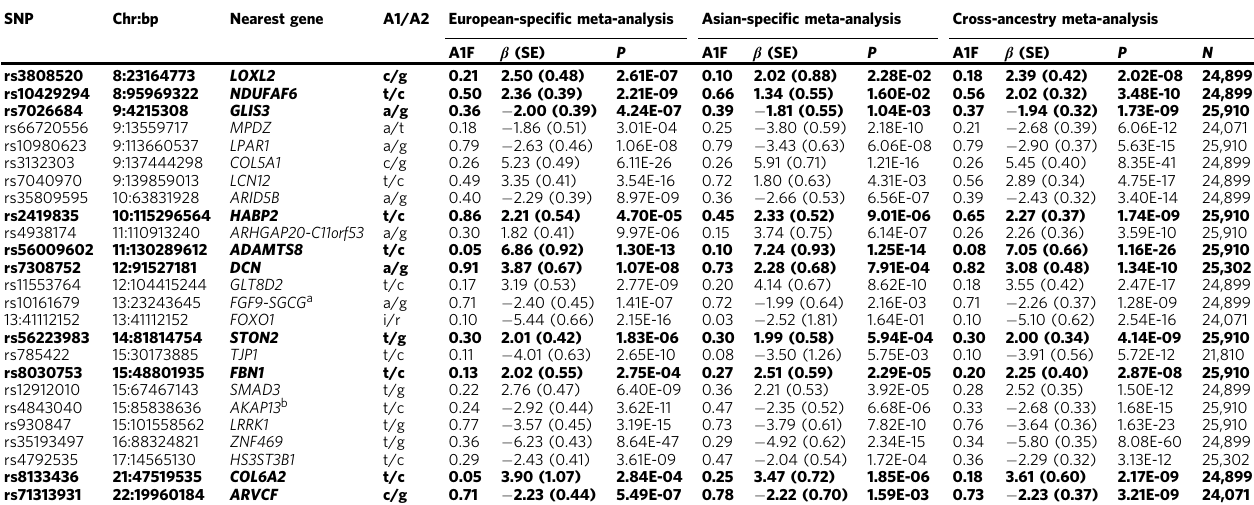
Table 2 Results from cross-ancestry meta-analysis (chromosomes 8 – 22)